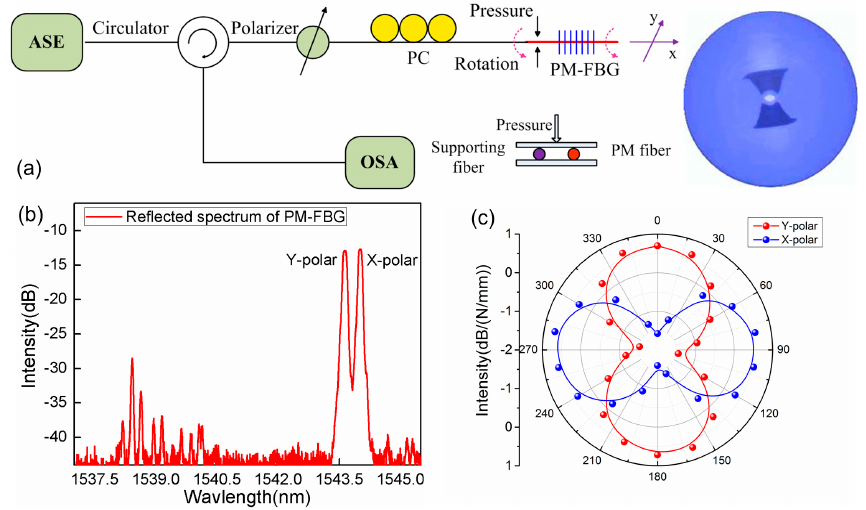
Figure 12. ( a ) Experimental setup for vector pressure measurement; ( b ) Reflection spectrum of PM-FBG with two polarized mode resonances; ( c ) Orthogonal responses of two polarized mode versus transverse stress.